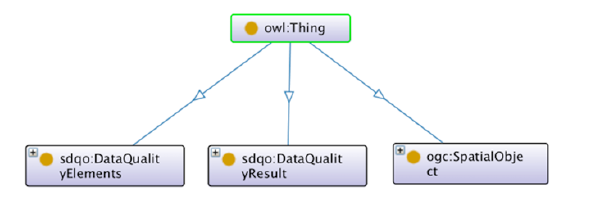
Figure 3. SDQO ontology, top classes